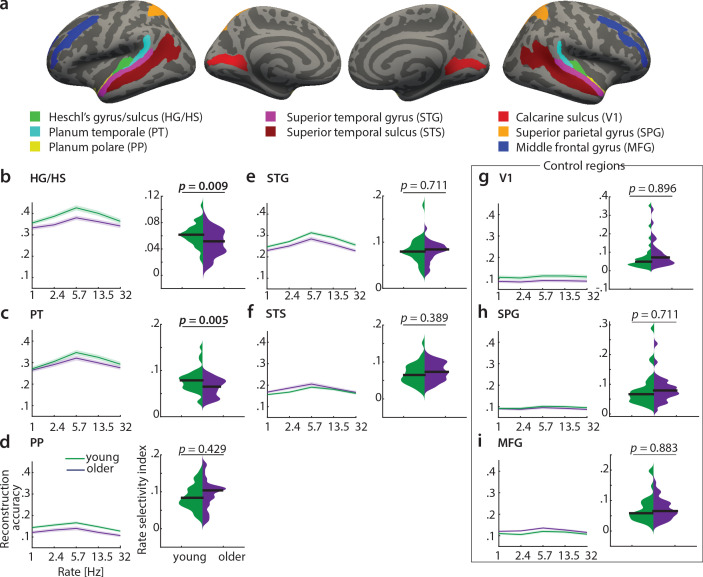
Decoding of temporal rate from regions of interest (ROIs).(a) ROIs derived from the FreeSurfer atlas (Destrieux et al., 2010) are displayed on FreeSurfer’s fsaverage template. Mean (± SEM) reconstruction accuracy profiles (left) and selectivity index (right) per age group for temporal rate in (b) Heschl’s gyrus and sulcus, (c) planum temporale, (d) planum polare, (e) superior temporal gyrus, (f) superior temporal sulcus and the control regions (g) calcarine sulcus, (h) superior parietal gyrus, (i) middle frontal gyrus. The selectivity index (SI) was compared per ROI between age groups using an exact permutation test. When removing the young-subject SI exceeding the grand average by ±2 SD, the SI age difference remains significant in HG/HS (p=0.008), and in PT (p=0.04). Consistently, our alternative measure of selectivity, variance across rate bins, was significantly higher in young than older adults in HG/HS (p=0.0004) and PT (p=0.0003). See Figure 7—figure supplement 1 for the reconstruction accuracies z-scored with respect to the empirical null distribution in an exemplary region HG/HS. See Figure 7—figure supplement 2 for group maps of the rate selectivity index obtained from encoding models. See Figure 7—figure supplement 3 for decoding of spectral scale and frequency from ROIs.